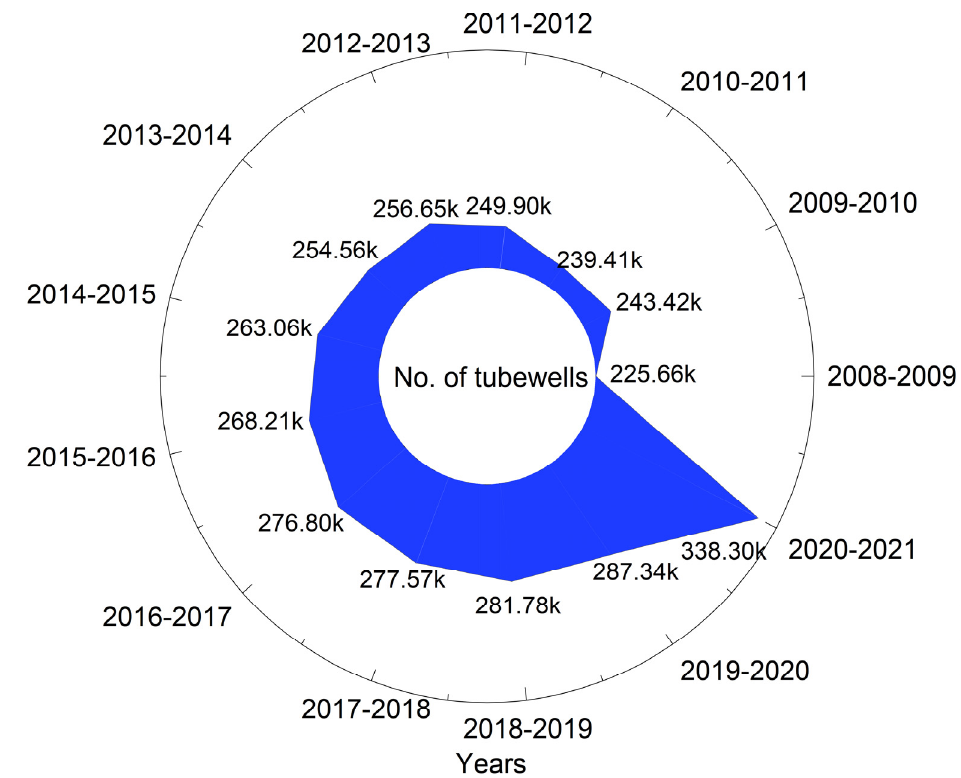
Figure 12. Change in tubewell density from 2008–2009 to